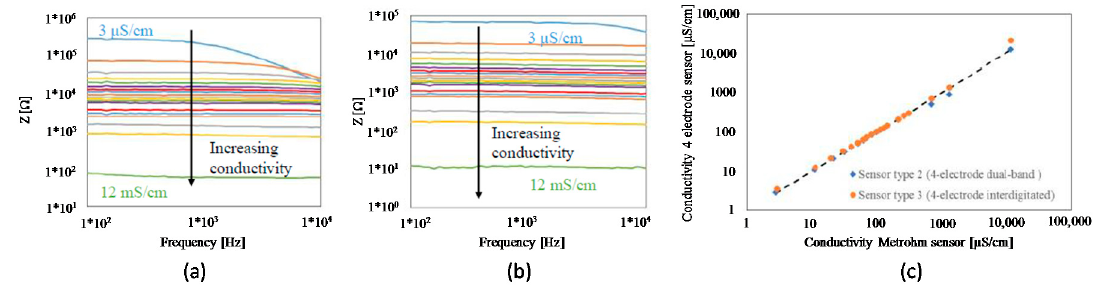
Figure 3. Impedance for the microfabricated 4-electrode sensors type 2 ( a ) and type 3 ( b ). ( c ) Conductivity measured with the microfabricated 4-electrode sensors as function of conductivity determined with the commercial sensor. The conductivity is determined from the impedance at 280 Hz. The dashed line represents the line y = x, with unity